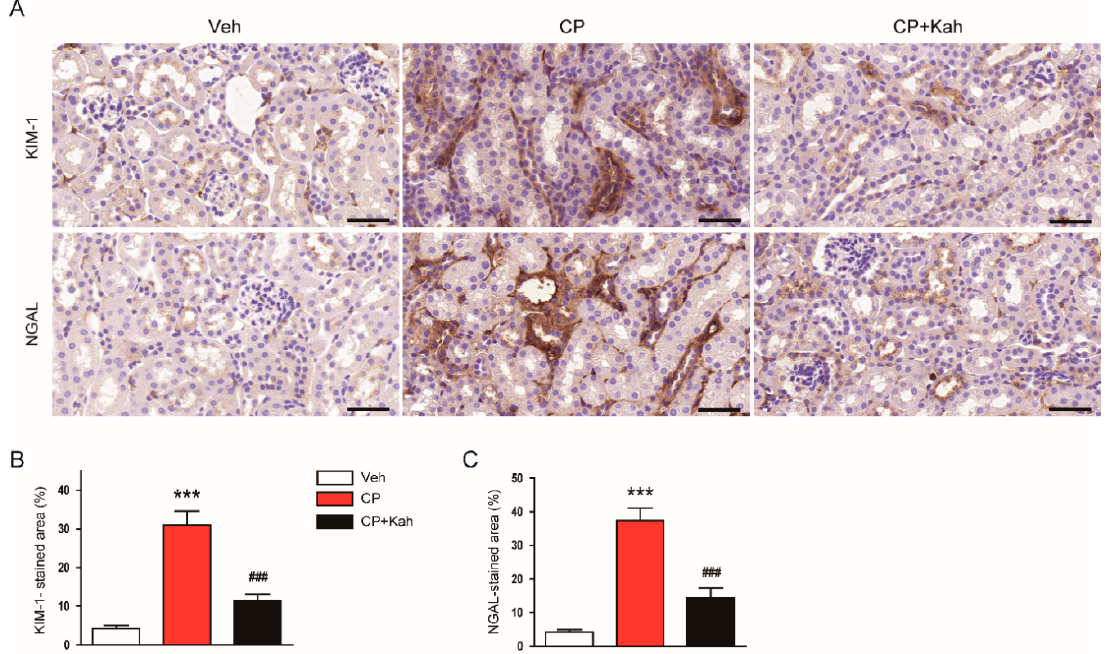
Figure 4. Effect of kahweol on tubular injury markers in cisplatin-injected mice. ( A ) Immunohistochemical staining of kidney tissues for kidney injury molecule-1 (KIM-1) or neutrophil gelatinase-associated lipocalin (NGAL). Scale bar = 50 µ m. ( B ) Percentage of stained area for KIM-1. ( C ) Percentage of stained areas for NGAL. n = 8 per group. *** p < 0.001 vs. Veh. ### p < 0.001 vs.